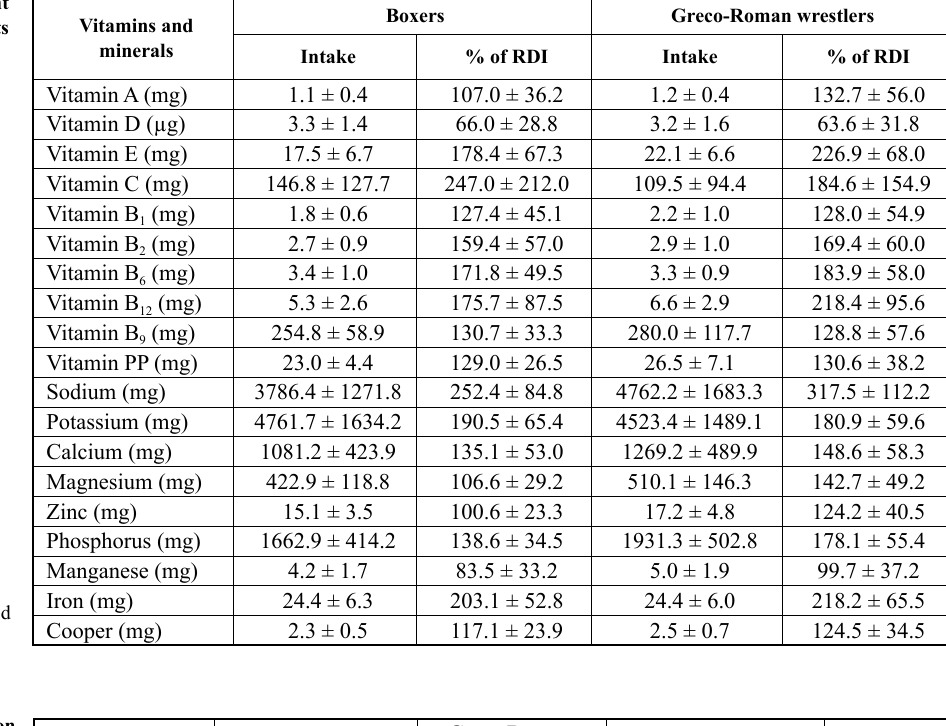
Table 6. The distribution of athletes’ (in per cent) intake of micronutrients (according to the type of combat